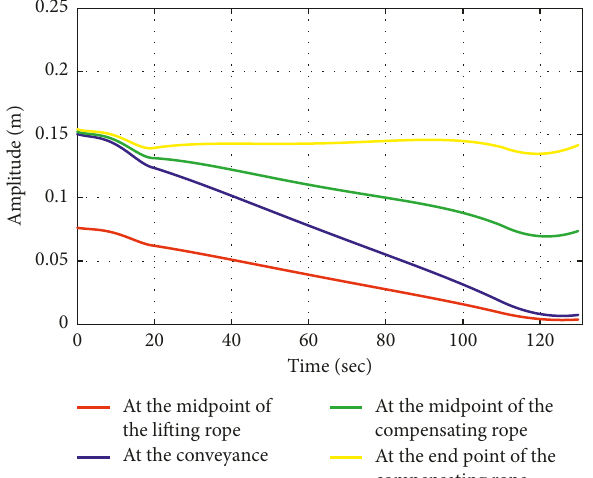
Figure 7: Longitudinal response trends of the traction system at different positions.